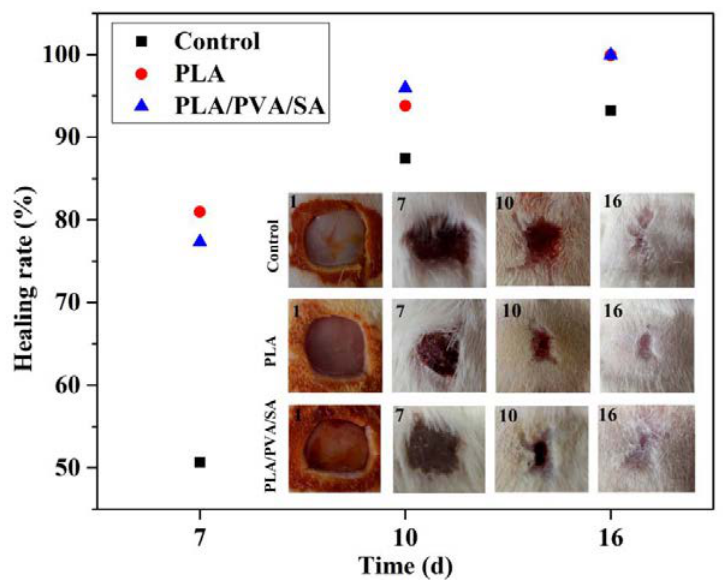
Figure 8. Healing rate and wound closure images in PLA fiber-treated and PLA/PVA/SA fiber-treated on days 1, 7, 10, and 16.